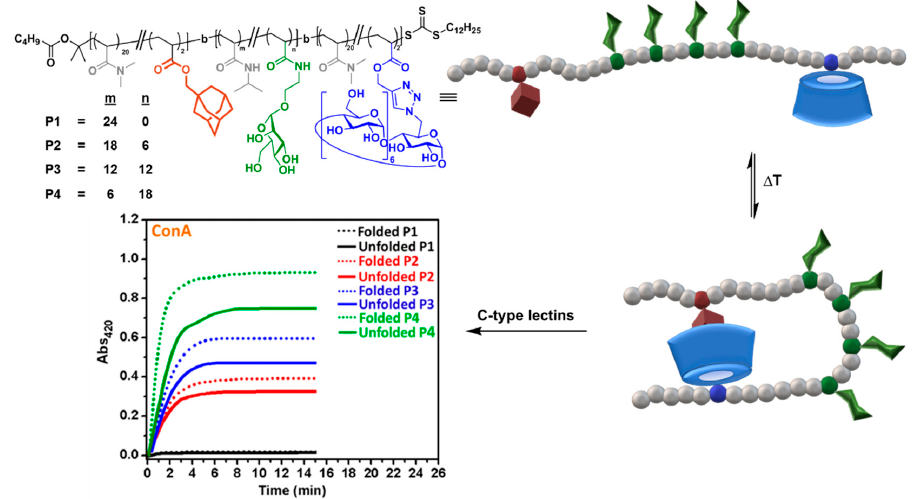
Figure 8. Triblock glycocopolymers bearing β CD units designed by Bercer and coworkers [63] to modulate the C-type lectin binding properties through intramolecular host–guest control of the folding state. Adapted with permission from Reference [63], https://pubs.acs.org/doi/abs/10.1021/acs.biomac.8b00600. Copyright 2018 American Chemical Society. ConA, concanavalin A.